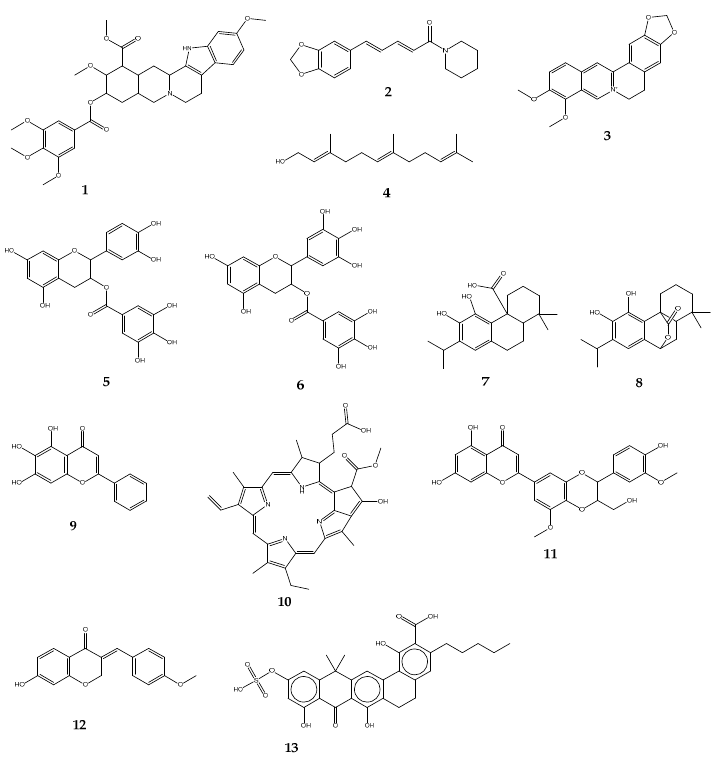
Figure 5. Chemical structures of some naturally-occurring efflux pump inhibitors. Reserpine (1), Piperine (2), Berberine (3), Farnesol (4), Epicatechin gallate (5), Epigallocatechin gallate (6), Carnosic acid (7), Carnosol (8), Baicalein (9), Porphyrin pheophorbide A (10), 5’-methoxyhydnocarpin (11), Bonducellin (12), EA-371α (13).